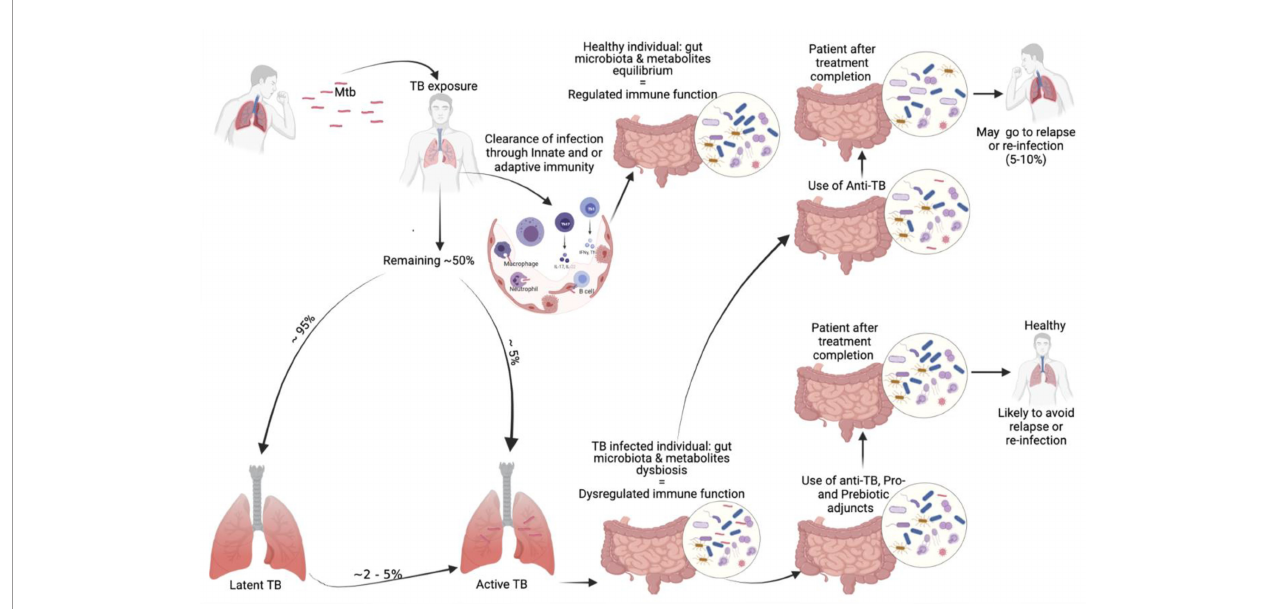
FIGURE 2 | Our proposed involvement of the microbiota in TB infection and possible microbiota-targeted-adjuvants during tuberculosis